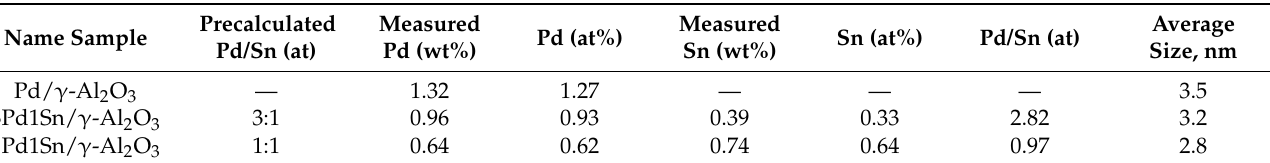
Table 1. Pd and Sn content according to ICP-OES (wt%) and corresponding (at%) content, and average nanoparticle diameter corresponding to the histograms in Figure obtained from TEM